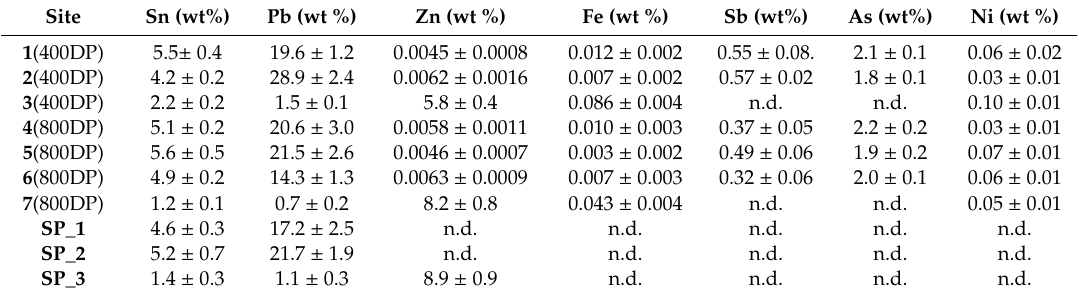
Table 2. Results of LIPS measurements on Egyptian statuette (Inv. 5409). One to seven measurements were performed with the new DPP-LIPS. SP_1–3 measurements performed with the SPP-LIPS system described in Agresti et al. [18]. n.d. = not detected (because below LOD).